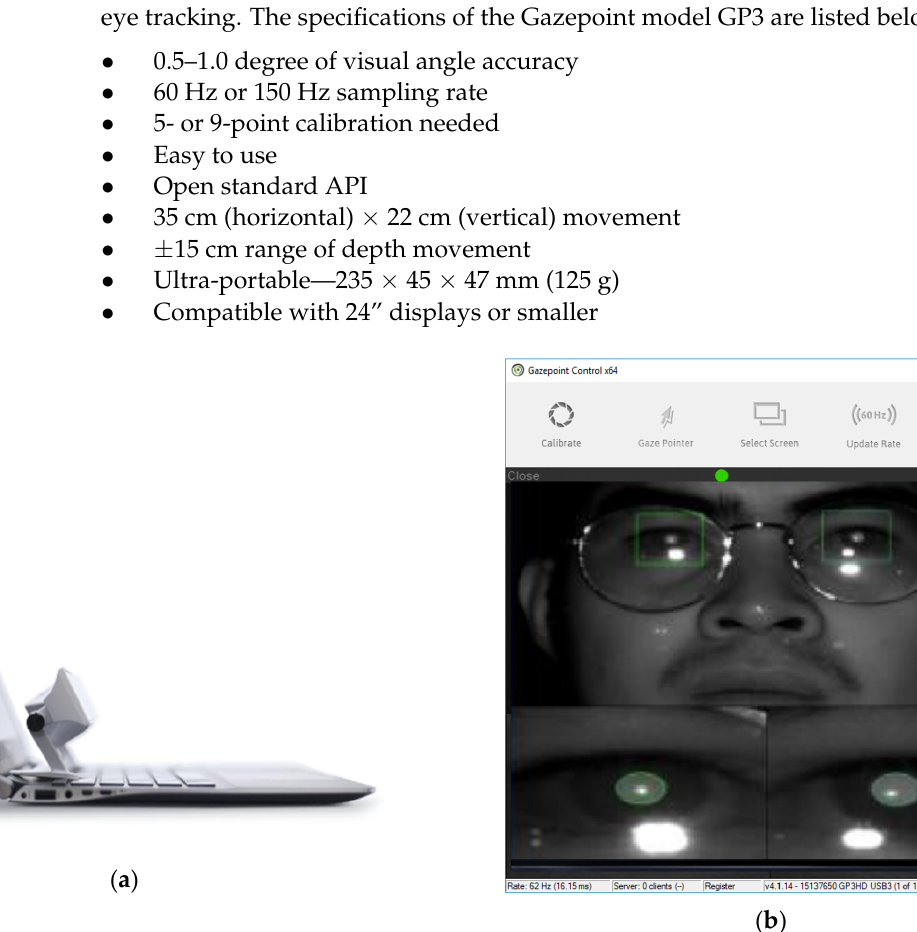
Figure 2. Gazepoint GP3 eye tracker [23] : ( a ) Gazepoint GP3 eye tracker mounted on notebook; ( b ) calibration software.